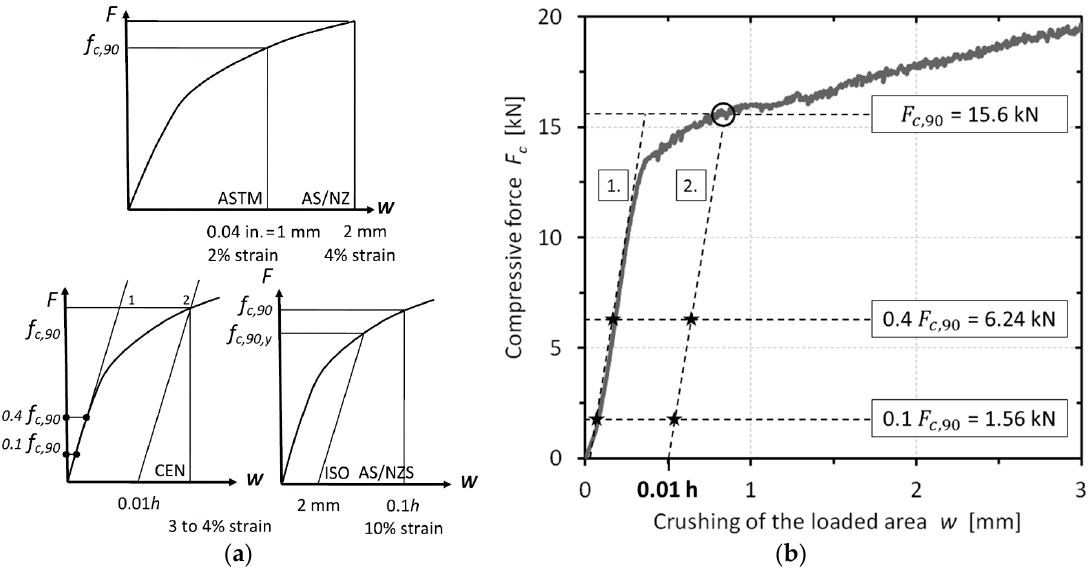
Figure 5. Standardized definitions ( a ) of the maximal elastic force F c ,90 in compression perpendicular to the grain, from [13]. Application of the European Standard EN 408 [12] on the mechanical characterization of scots pine ( Pinus sylvestris L.) ( b ), from [10].